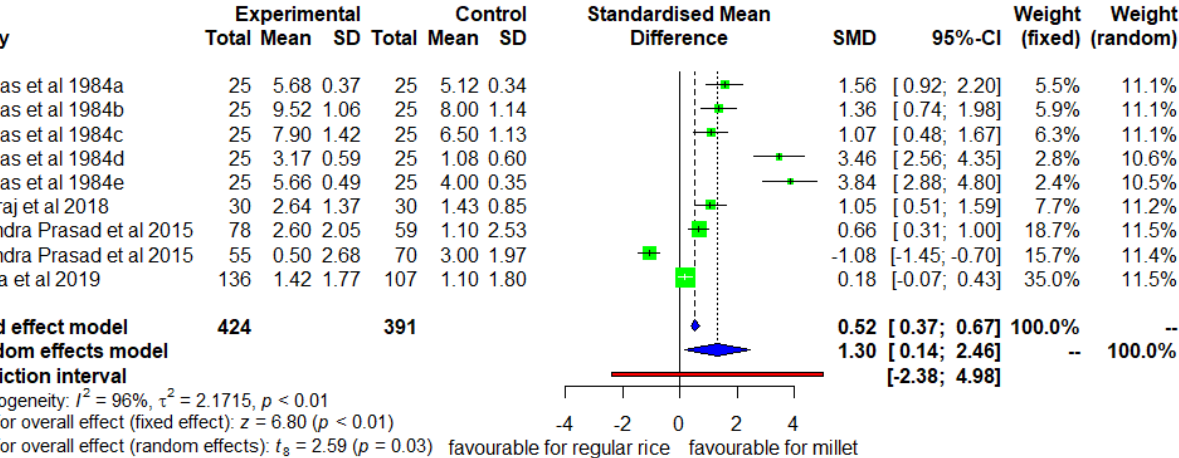
Figure 3. Effect of consuming a millet-based diet on mean weight change compared to a regular rice-based diet.